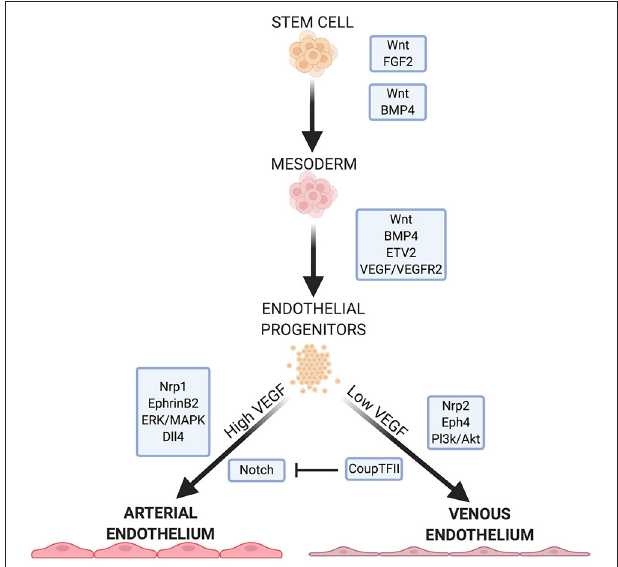
FIGURE 1 | Summary of some important factors and pathways in EC development. Wnt signaling is necessary for specification of mesoderm and proper function in arterial ECs. FGF2, BMP4, and ETV2 are crucial for mesoderm formation and EC specification. VEGF/VEGFR2 signaling further specifies EC fate, with high and low concentrations leading to arterial or venous EC specificity, respectively. VEGF signaling continues to mediates downstream pathways and receptors that further direct arterial or venous EC